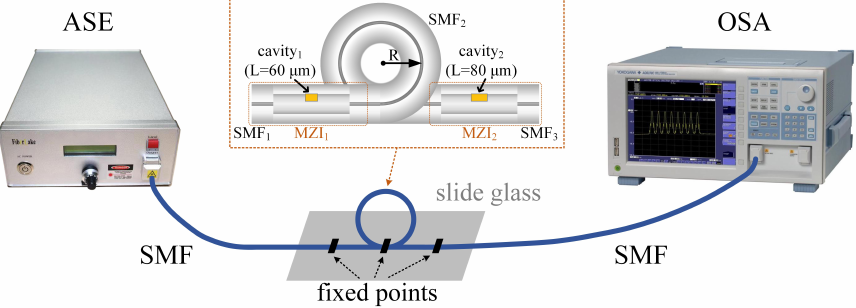
Figure 4. Schematic diagram of the experimental setup for measuring the transmission spectra of the cascaded MZI samples. (ASE: amplified spontaneous emission, OSA: optical spectrum analyzer, inset: schematic diagram of the cascaded MZI